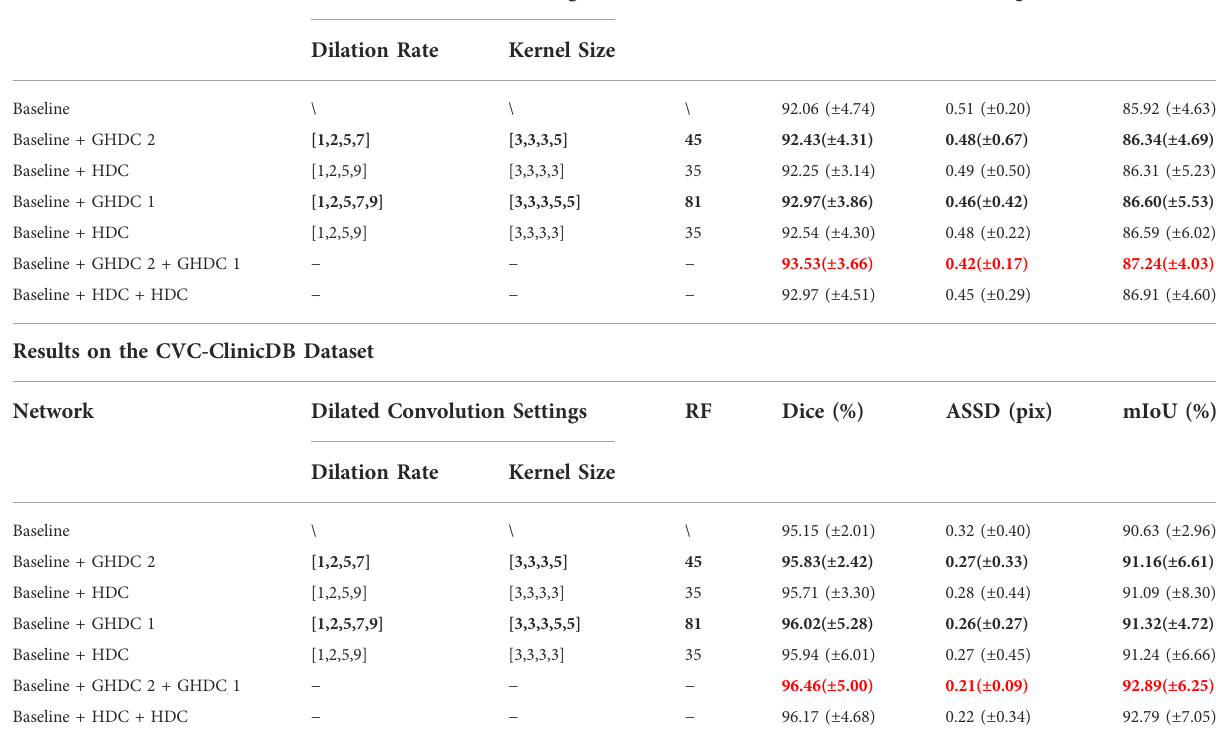
TABLE 4 Experimental Results of GHDC and HDC Implementations Based on the Two Public Datasets of Colorectal Polyp Segmentations (The best results are marked in red bold font). Results on the Kvasir-SEG Dataset